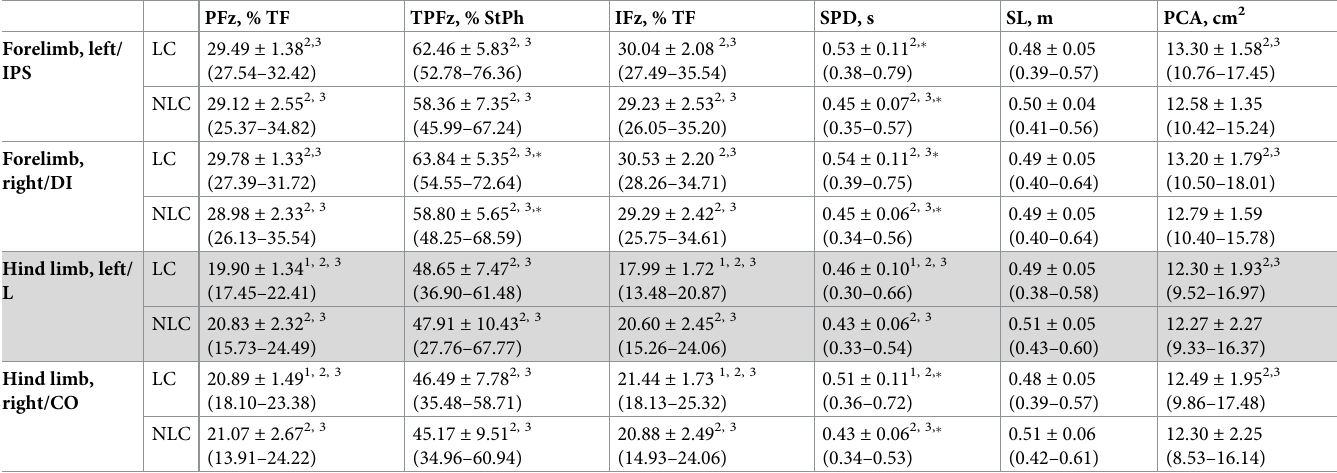
Table 2. Ground reaction forces (normalized to %TF) and temporospatial parameters of 20 lame cats and 15 sound cats.